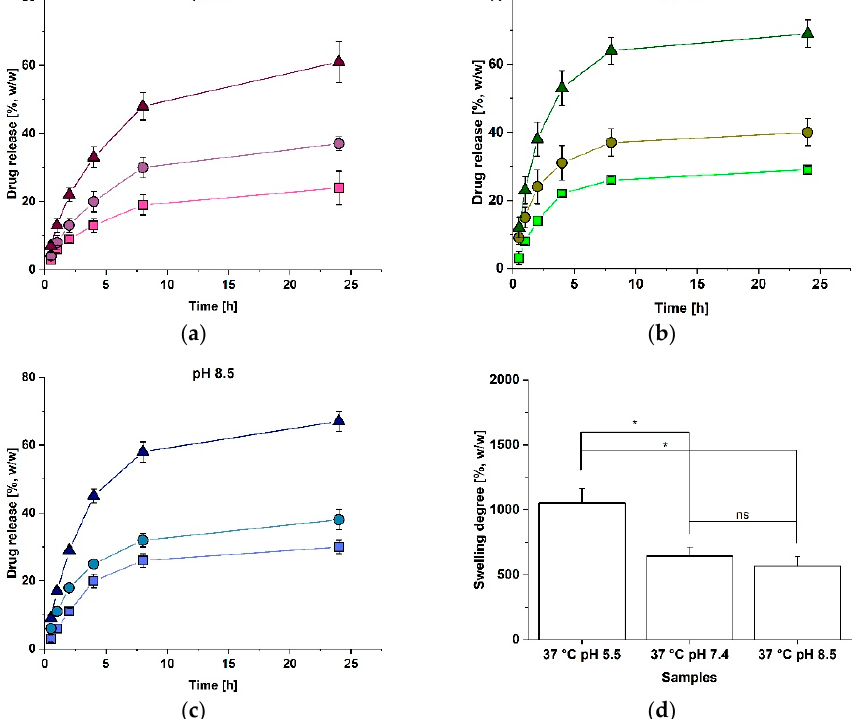
Figure 2. Vancomycin release and the swelling properties of the AC-laminates at different pH values. The release of vancomycin was determined over 24 h in the upper chamber (squares), the lower chamber (dots) and in total (triangles). The amount of the released vancomycin was calculated according to the amount (1 mg) loaded into the Atelocollagen layer. This layer of the AC-laminate was facing the upper chamber of the sample holder. Error bars represent the standard deviation (n = 3); ( a ) Release at pH 5.5; ( b ) Release at pH 7.4 (data obtained from Kilb et al. [16]); ( c ) Release at pH 8.5; ( d ) Swelling degree after 2 h of incubation at 37 °C at different pH values. A Kruskal–Wallis– ANOVA was used to determine the significance of the difference of the mean swelling degrees at p ≤ 0.05, indicated by an asterisk. Non-significant differences are indicated by ns.